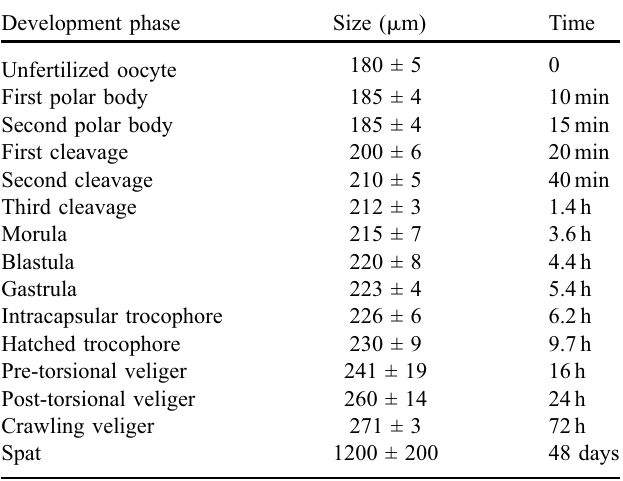
Table 1. Early development of Cittarium pica . Time of appearance and size at various developmental